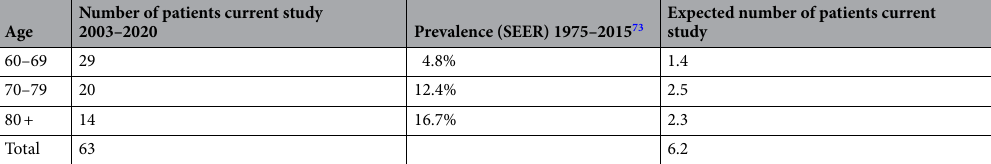
Table 5. Men 60-year-old and above in the current study and corresponding USA prostate cancer prevalence.